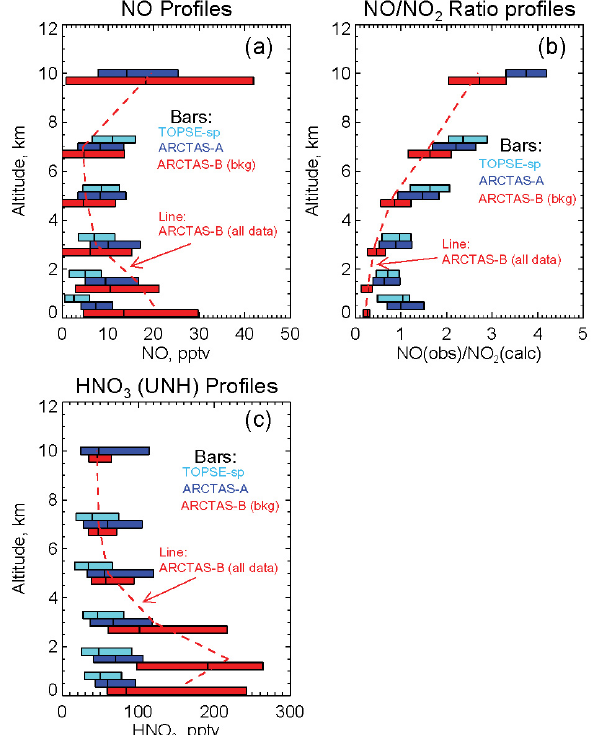
Fig. 4. Profiles of (a) NO, (b) NO/NO 2 and (c) HNO 3 during ARC- TAS and during TOPSE-sp. Bar plots and dashed lines are as de- scribed in Fig.